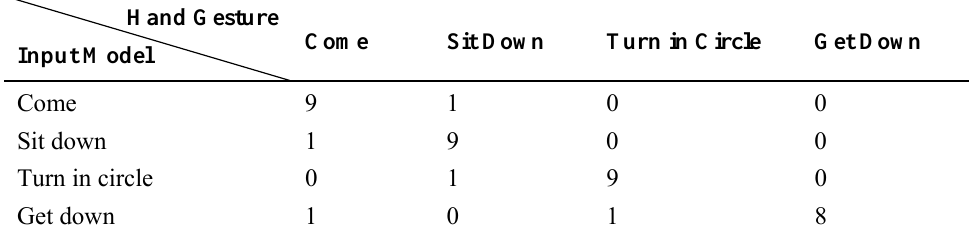
Table 6. Confusion matrix for recognition results of dynamic hand gestures with a Kalman filter, plus repetitive segment detection.